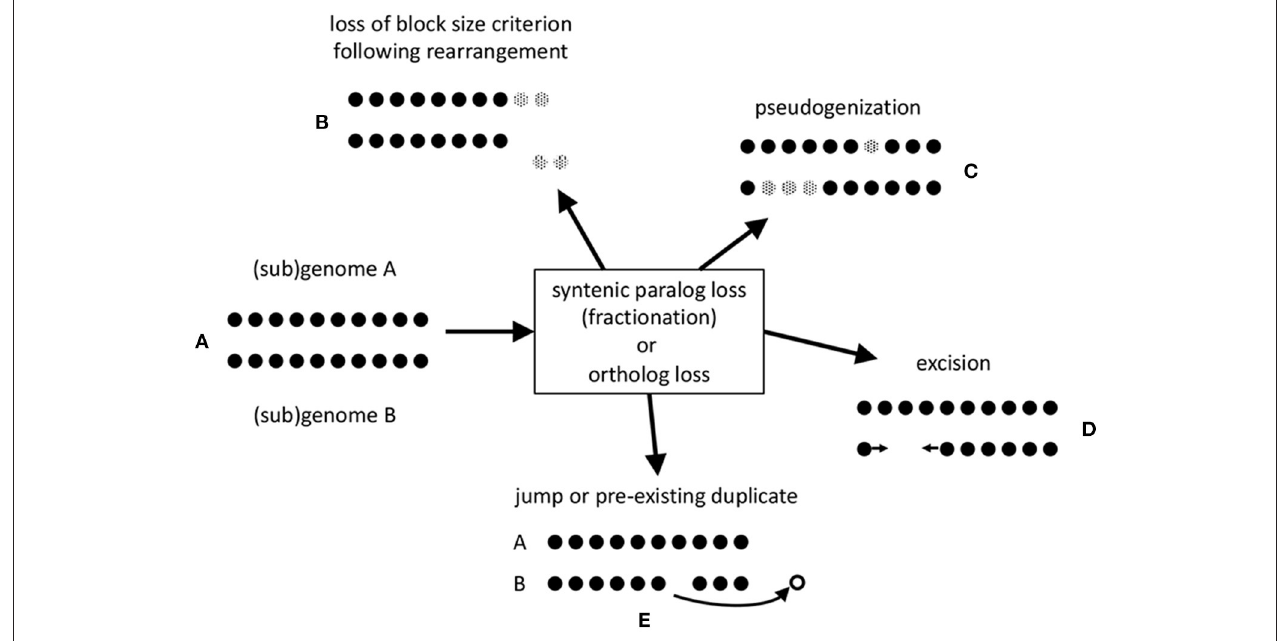
FIGURE 1 | Mechanisms of loss of gene pair homology after speciation or polyploidization. (A) Synteny block made up of co-linear homologous pairs. (B) erosion of synteny block by translocation to a remote chromosomal location of a portion of sub-threshold length. (C) Pseudogenization. Genes rendered inoperable represented by gray dots. (D) Excision of DNA fragment including one or more genes. Arrows represent a new adjacency after the loss of the excised genes. (E) Jump of one member of pair to a different genomic location, or loss of only one of two or more homologs of the same gene.